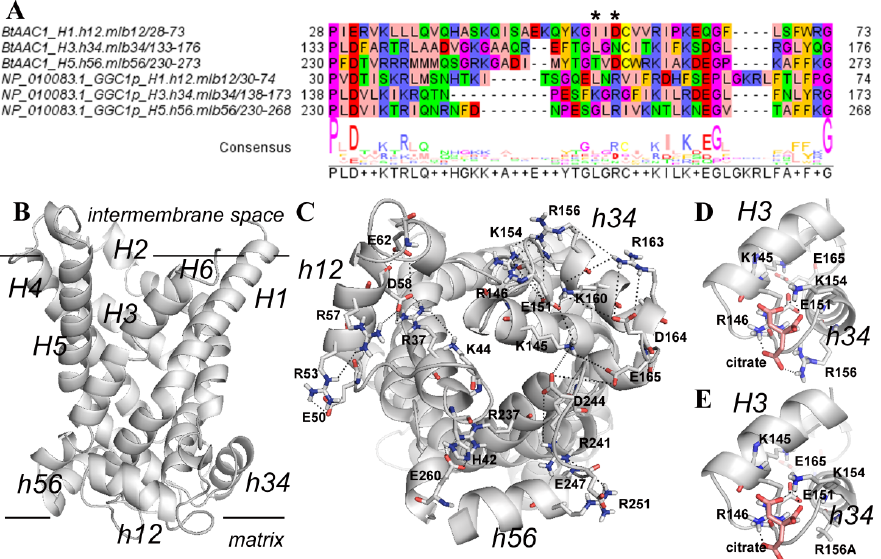
Figure 9. Ggc1p-citrate interactions allowing Ggc1p citrate-mediated uptake of GTP. Panel A . Inter-repeat sequence analysis of Ggc1p and BtAAC1. The sequence alignment of the three repeats of Ggc1p and the bovine ADP/ATP carrier (BtAAC1) is reported to highlight residues between the first part and the second part of the MC sequence motif. Amino acids are colored according to the default JalviewZappo style (http://www.jalview.org/, accessed on 15 May 2022). A consensus sequence is reported at the bottom of the figure, where the sequence motif of the mitochondrial carrier family PX[D/E]XX[K/R] EGXXXXAr[R/K]G is brought into evidence. “*” symbols indicate the position of R53, K154, R156, and R251 in the three Ggc1p repeats. Notably, panel ( A ) shows that Ggc1p repeat 2 (the central row of the alignment panel) is the only Ggc1p repeat harboring two basic residues, K154 and R156, which align with the residues of the regulatory motif at the level of the [D/N]C dipeptide observed in the three BtAAC1 repeats, according to [40]. Panel ( B ). The lateral view of the Ggc1p 3D structural model in cytosolic conformation is reported in white cartoon representation. The transmembrane helices H1-6 and the short helices h12, h34 and h56 parallel to the membrane plane are indicated by italic black labels. The two horizontal black lines on the top and on the bottom of the Ggc1p 3D model denote the boundaries of the inner mitochondrial membrane. Panel ( C ). The bottom view of Ggc1p is reported in white cartoon representation. Basic and acidic residues participating in the complex ion pair network described in the text are reported in white sticks and labeled. Short helices parallel to the mitochondrial membrane plane are indicated by italics labels (h12, h34, h56). Panels ( D , E ) . Zoomed views of the proposed citrate binding region in the Ggc1p wild-type model (panel ( D )) and in the Ggc1p R156A mutant model (panel ( E )) at the level of residues R156 and K154. Black dashed lines indicate ionic interactions and H-bonds. Transport experiments were performed using proteoliposomes reconstituted with wild-type or mutated Ggc1p (Figure 10). The citrate-induced [8- 3 H]GTP uptake (CIGU) was observed in K154A and R156A mutants but not in R53A and R251A mutants. The fact that CIGU in K154A and R156A mutants were markedly decreased with respect to that of wild-type Ggc1p strongly suggests that K154 and R156 play a crucial role in the binding of citrate to Ggc1p. In contrast, the replacement of R53, R156 or R251 with an alanine, but not of K154, enhanced the [8- 3 H]GTP/GTP exchange activity.